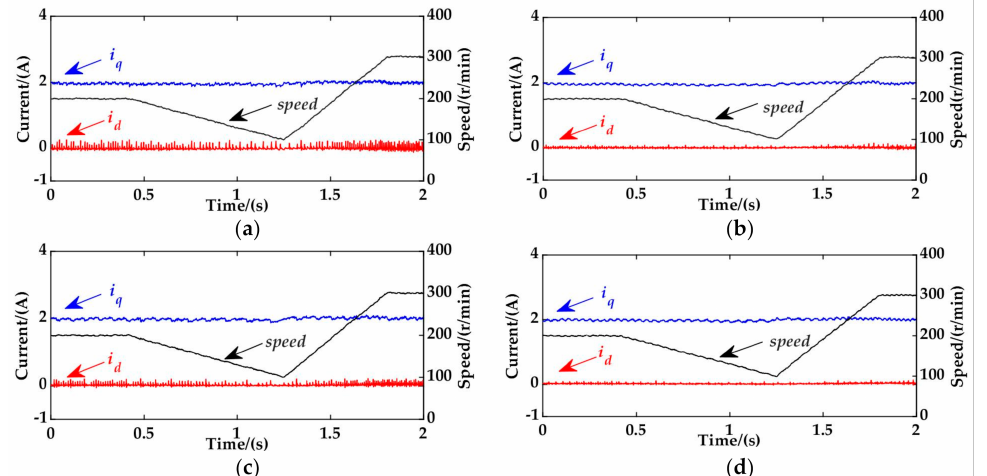
Figure 15. dq –axis currents and rotor speed during ramp response and 1 N · m load. ( a ) Compensation for PMSM FOC system with conventional DM–CZD. ( b ) Compensation for PMSM FOC system with proposed DP–CZD. ( c ) Compensation for current predictive control of PMSM with conventional DM–CZD. ( d ) Compensation for current predictive control of PMSM with proposed